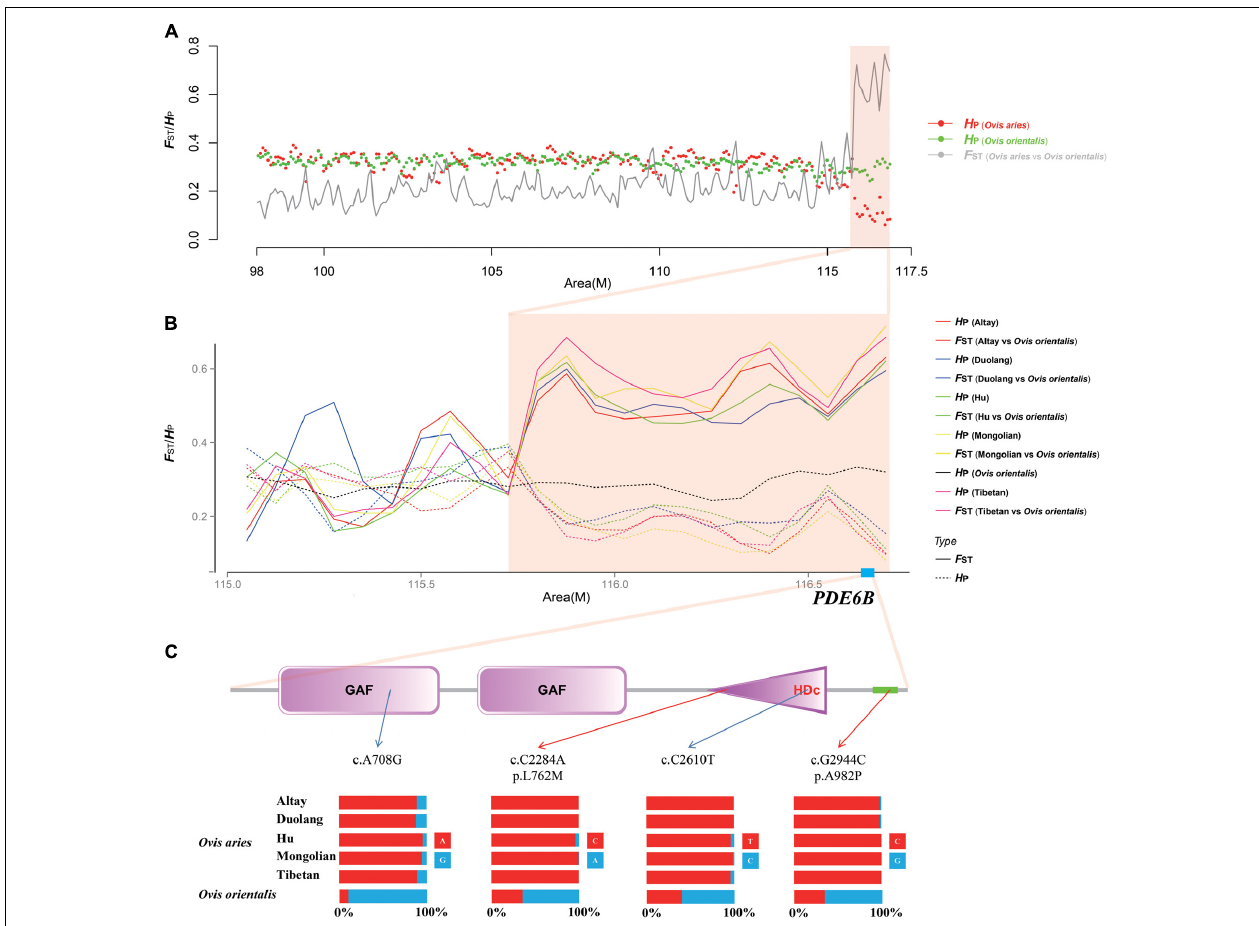
FIGURE 3 | Signatures of the selective sweep of the PDE6B gene region in domestic sheep. (A) Heterozygosity ( H P ) and fixation index ( F ST ) values across a chromosome 6 region harboring the PDE6B gene. The red and green dots represent the H P value of Ovis aries and Ovis orientalis , respectively. The gray line represents the F ST values between Ovis aries and Ovis orientalis . (B) Heterozygosity ( H P ) and fixation index ( F ST ) values around the PDE6B gene region in Asian Mouflon ( Ovis orientalis ) and five indigenous Chinese sheep breeds. Unbroken and dotted lines represent F ST and H P value, respectively. (C) Structure and variations of the PDE6B gene. The pink box and triangle indicate the GAF (cGMP-activated PDEs, adenylyl cyclase, and Fh1A) and HDc (HD/PDEase) domains, respectively. The allele frequencies of four SNPs within the PDE6B gene across five indigenous Chinese sheep breeds and Asian Mouflon ( Ovis orientalis ).